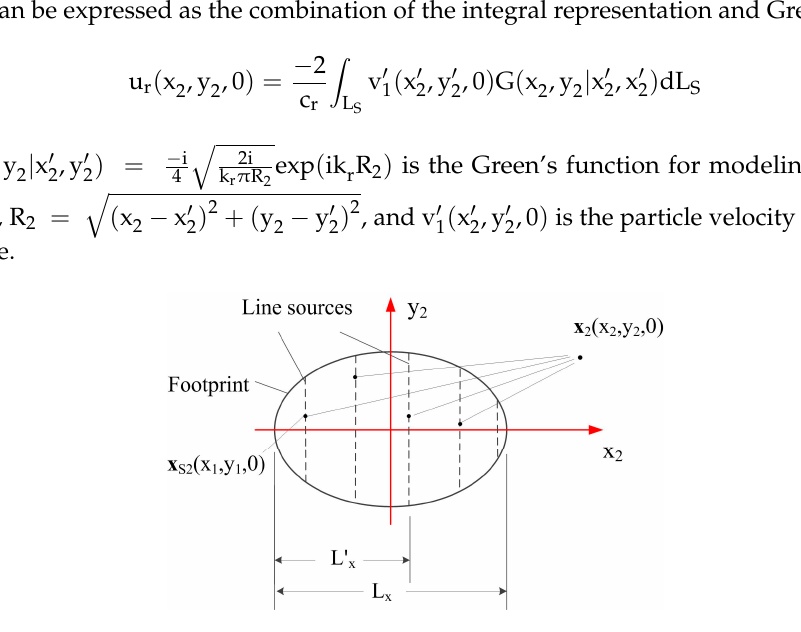
Figure 3. Geometry for calculating Rayleigh wave beams using an area sound source in the x-y plane.